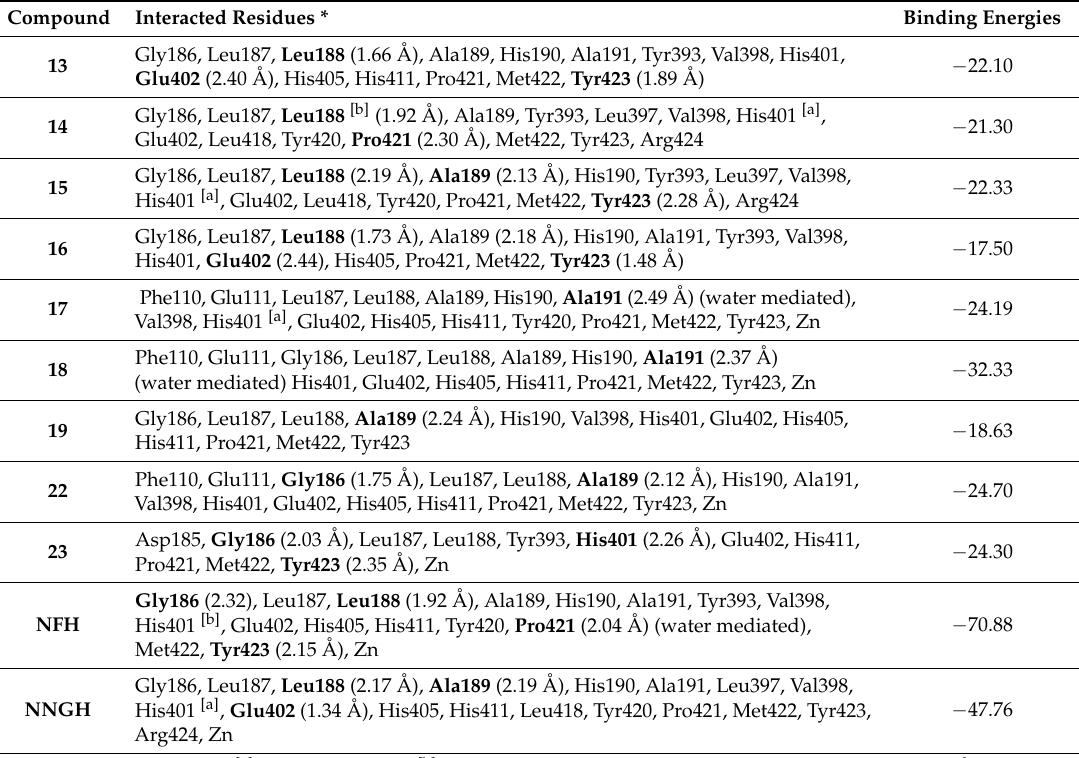
Table 3. Interacted residues of the tested compounds according to the docking